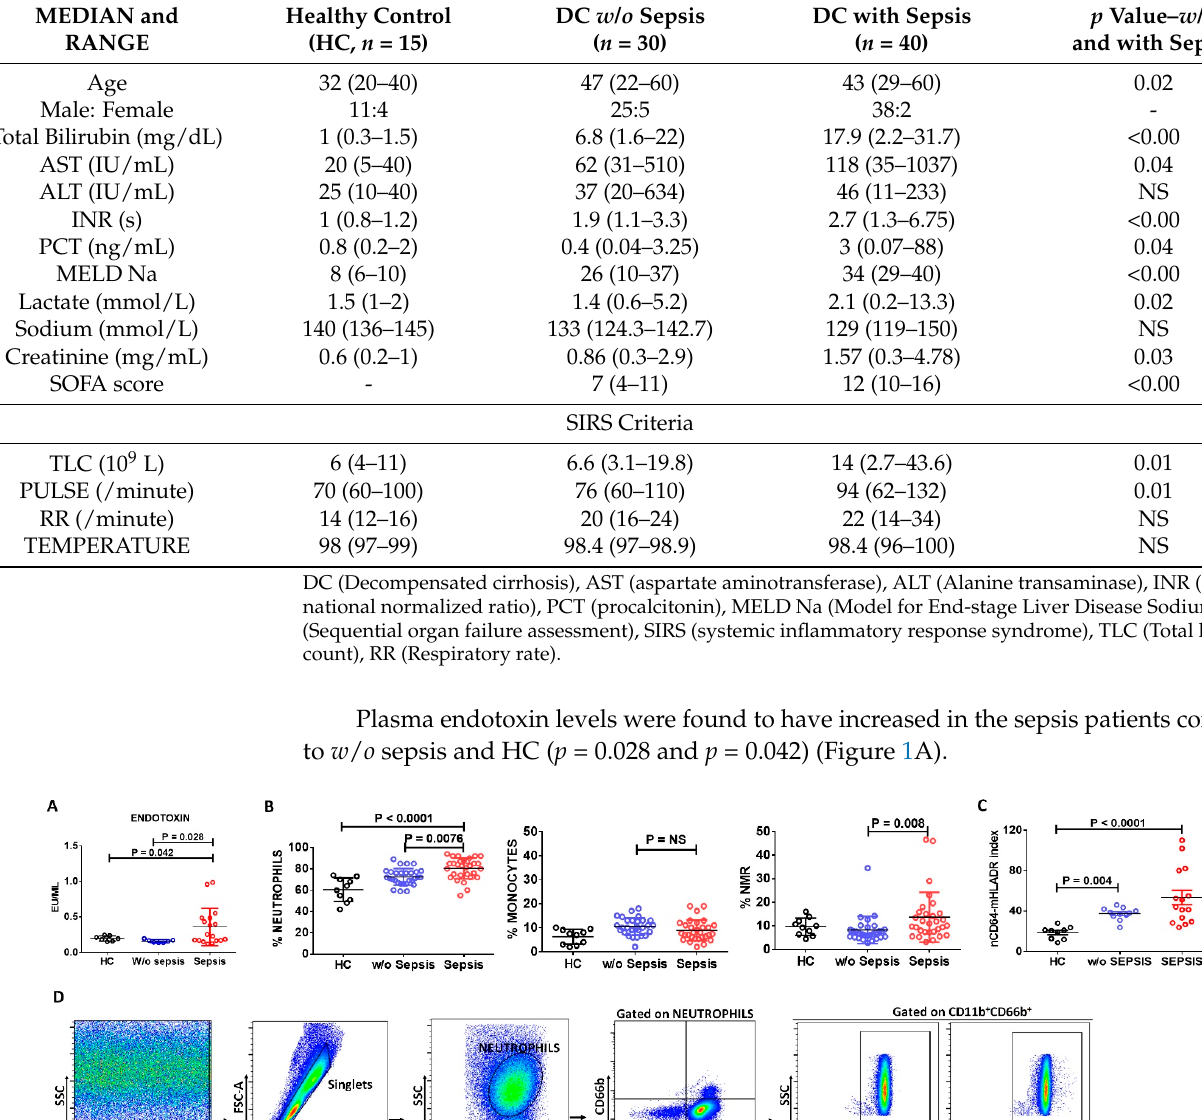
Table 1. Baseline clinical, as well as biochemical characteristics of study groups.